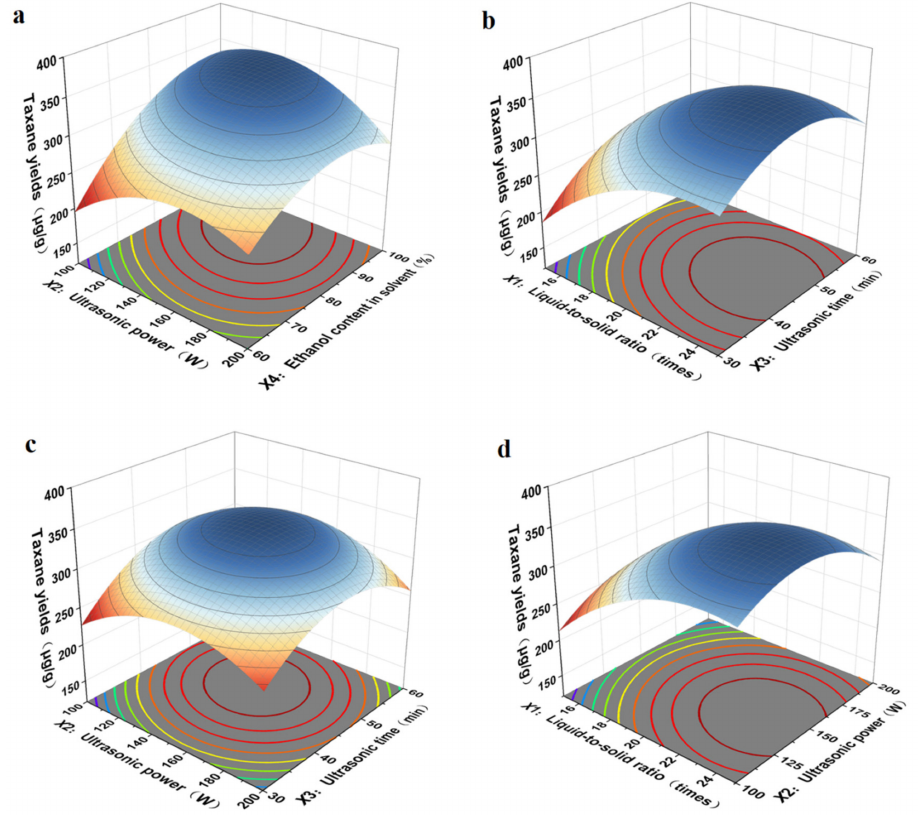
Figure 5. Interaction diagrams of various factors: ( a ) ultrasonic power and ethanol content in solvent, ( b ) liquid-to-solid ratio and ultrasonic time, ( c ) ultrasonic power and ultrasonic time, ( d ) liquid-to- solid ratio and ultrasonic